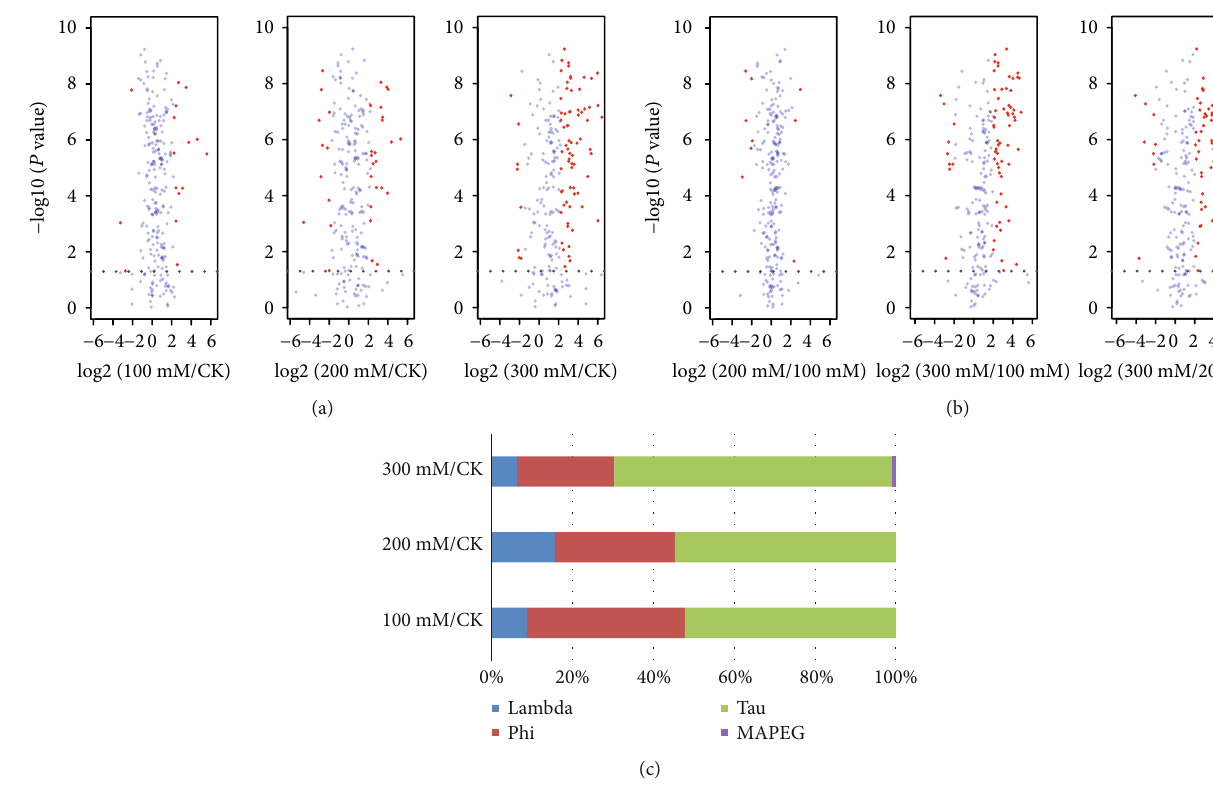
Figure 5: Expression analysis of all DEGs in various salt concentrations. (a, b) Di ff erentially expressed glutathione S-transferase genes under salt stress in common wheat. (c) The proportion of DEGs in di ff erent classes. Red dots represent DEGs, and blue dots represent non-DEGs in (a, b). Di ff erent classes are represented by corresponding colors in